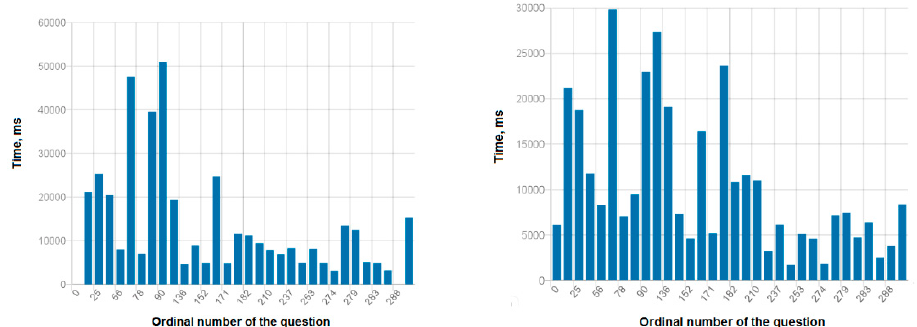
Figure 3. Reaction time of particular respondents to the questions.